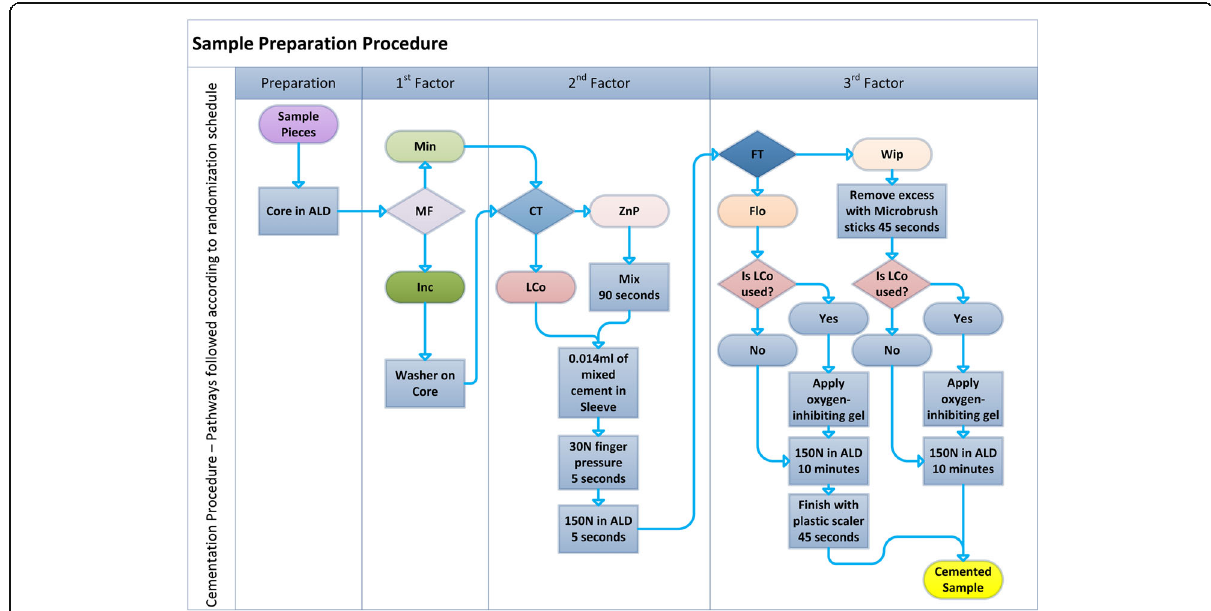
Fig. 1 A randomly followed path that resulted in a cemented experimental crown. The abutment was secured in the Axial Loading Device (ALD) holder, a washer of known thickness was placed on the abutment to introduce a known discrepancy (Inc) or not (Min), the crown was seated on the abutment either filled with a Luting Composite (LCo) or with Zinc Phosphate (ZnP) cement, and finally a procedure was applied to remove excess cement either before setting (Wip) or after